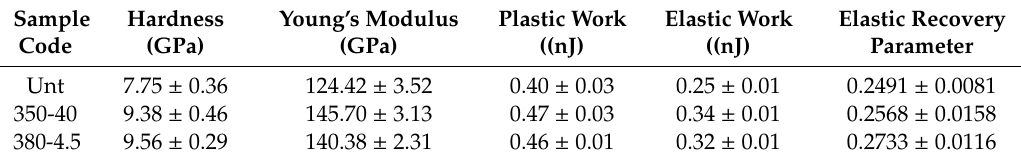
Table 3. Mechanical properties for the core material before and after CCT